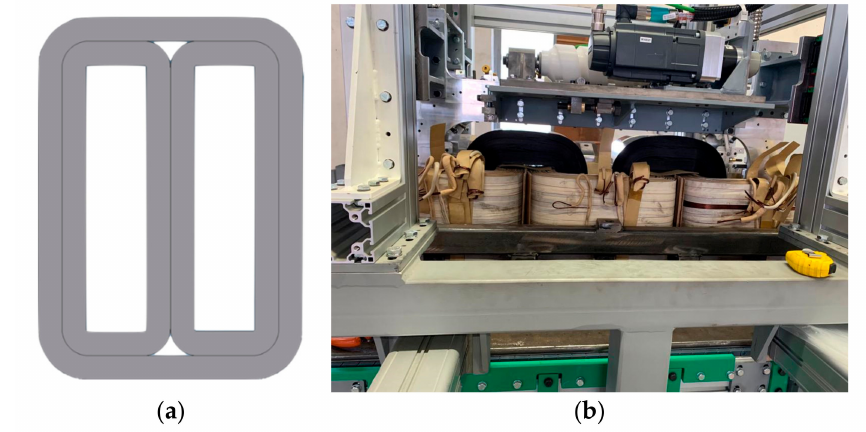
Figure 1. Three-legged transformer core made by amorphous alloy ( a ); transformer continuous core [15] during the automated manufacturing process ( b